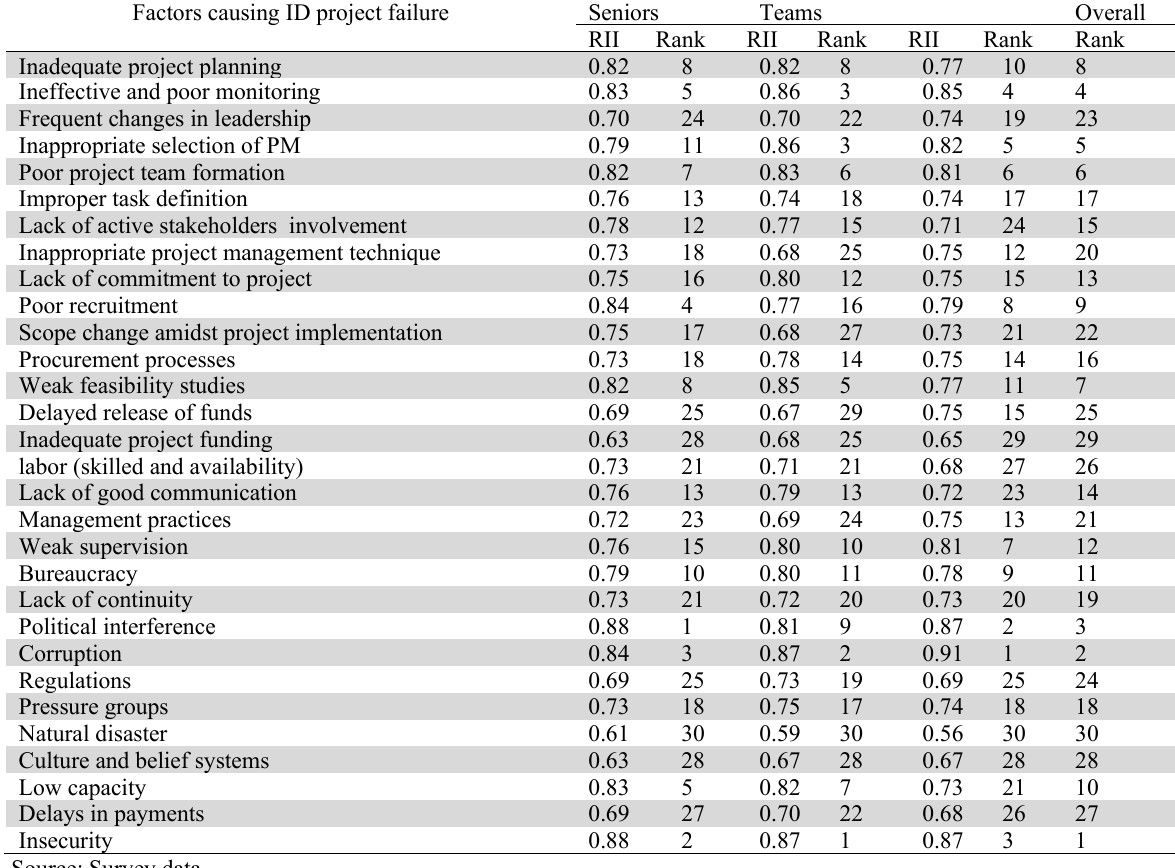
ranking of factors.